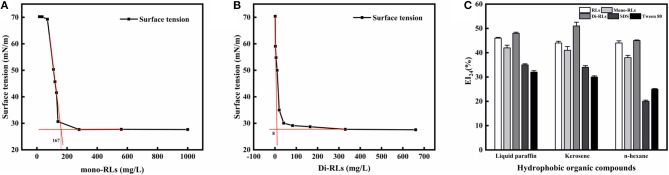
The evaluation of surface tension and emulsifying activity. Relationship between the surface tension and concentration of mono-RLs (A) and di-RLs (B); Emulsifying activity of five surfactants was assessed using three hydrophobic organic compounds (C). The EI24 of the five surfactants at 100 mg/L were measured and their emulsifying activities with different substrates (kerosene, liquid paraffin, n-hexane)0020were compared.